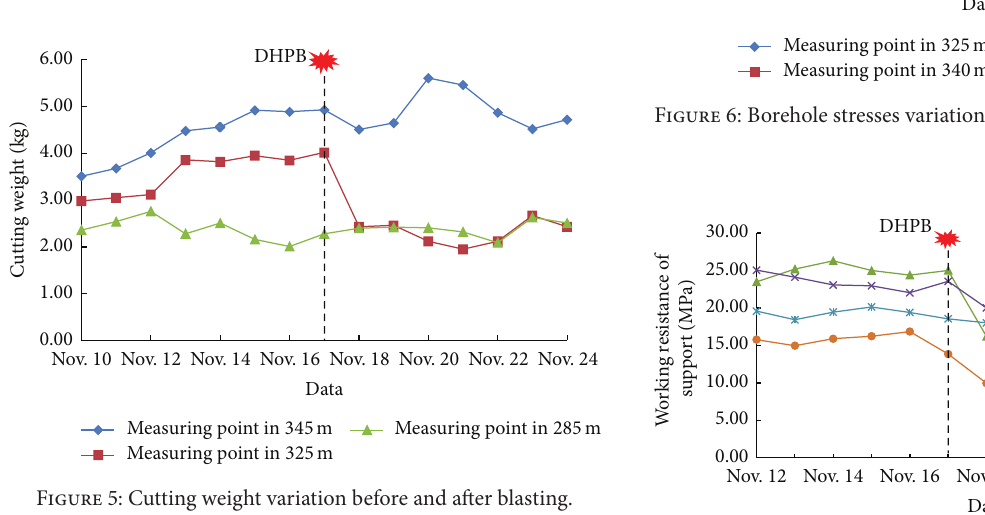
Figure 4: The arrangement of monitoring points.